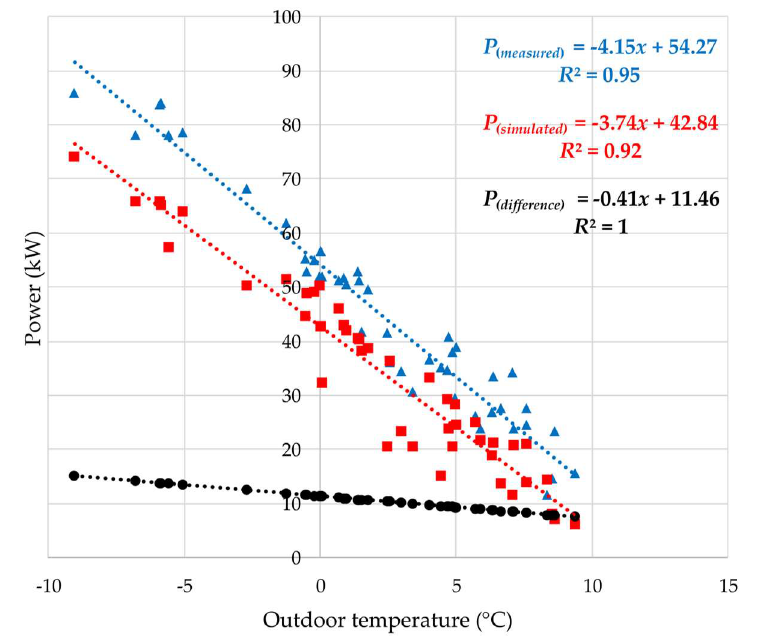
Figure 11. Mean power difference between measured and modelled heat power to hydronic radiators as a function of outdoor temperature daily values.